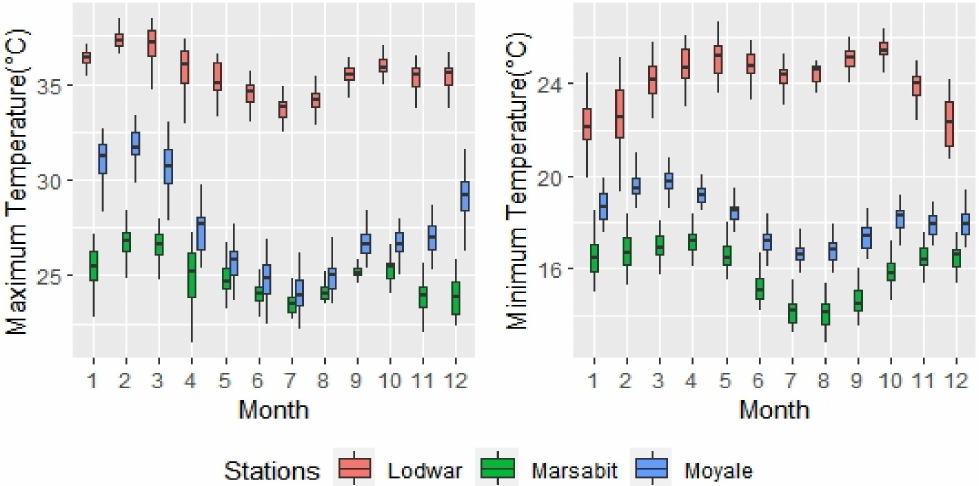
Figure 2. Monthly boxplots of the maximum and minimum temperature observations recorded by the land-based meteoro- logical stations of Lodwar, Marsabit and Moyale in the period of